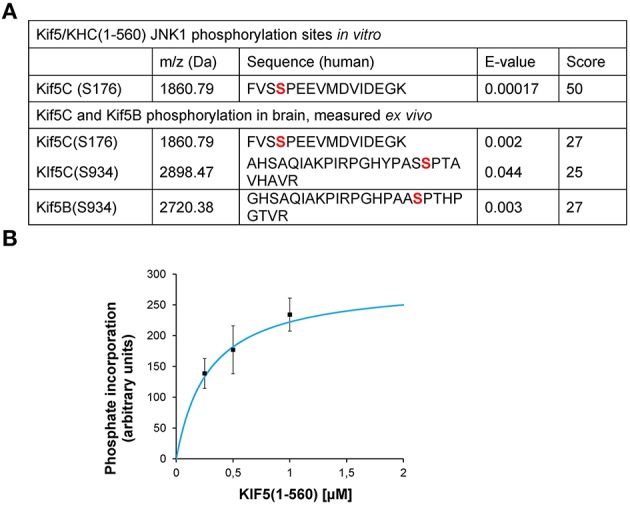
JNK3 phosphorylates KIF5C on S176, a site that is constitutively phosphorylated in brain. (A) The MS/MS phosphopeptide sequence obtained from in vitro phosphorylation of GST-KIF5C(1-560) by JNK3 shows that S176 (red) contained covalently bound phosphate. MS/MS analysis of phosphopeptides isolated from perinatal mouse brain showed that the same site (S176) was phosphorylated in vivo. Additional KIF5C and KIF5B phosphorylation sites are shown. (B) Kinetics of GST-KIF5C(1-560) phosphorylation by JNK3. Standard errors of the mean (S.E.M.) are shown.